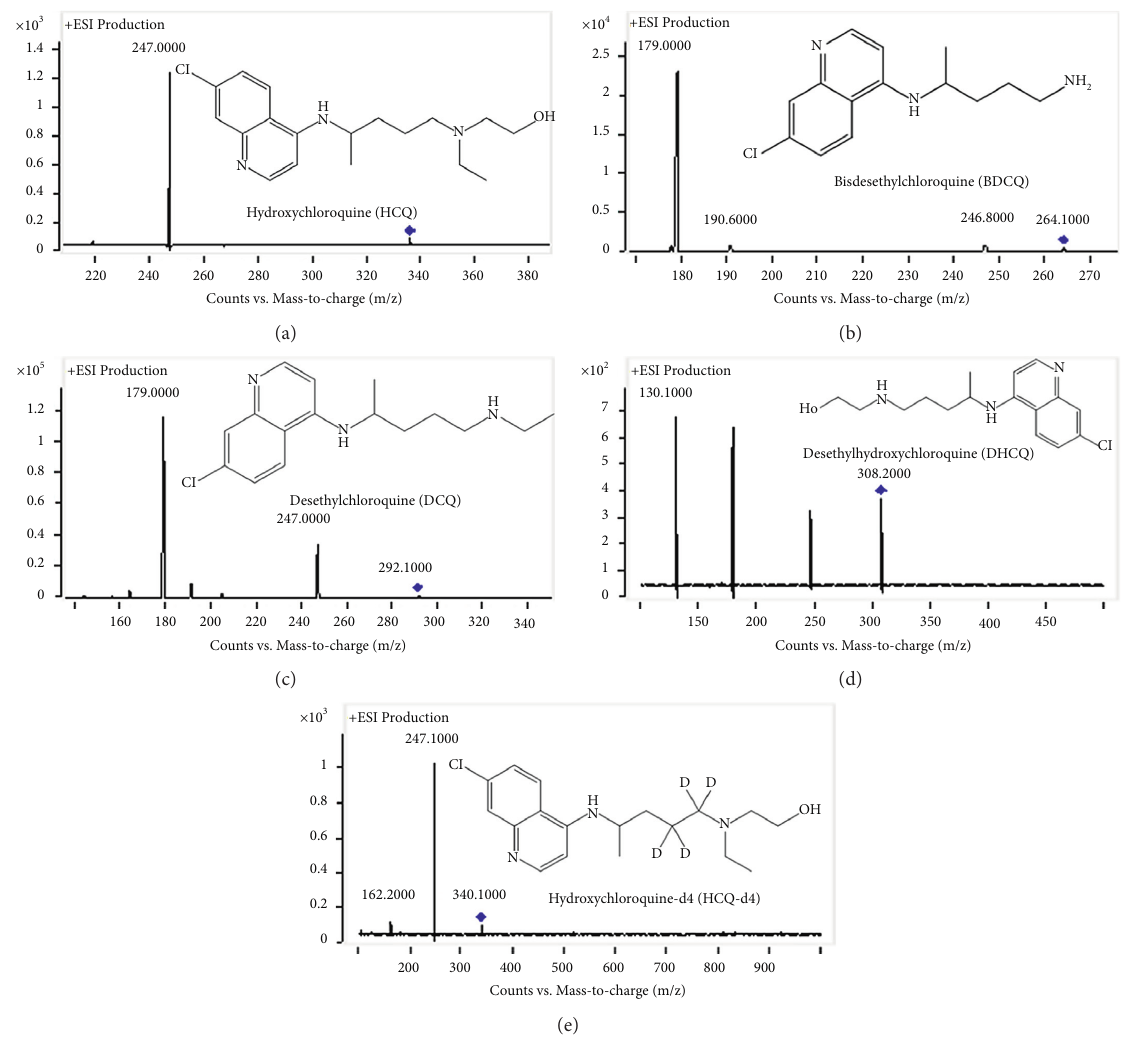
Figure 1: Chemical structures and full scan in product ion mode for HCQ (a), BDCQ (b), DCQ (c), DHCQ (d), and IS